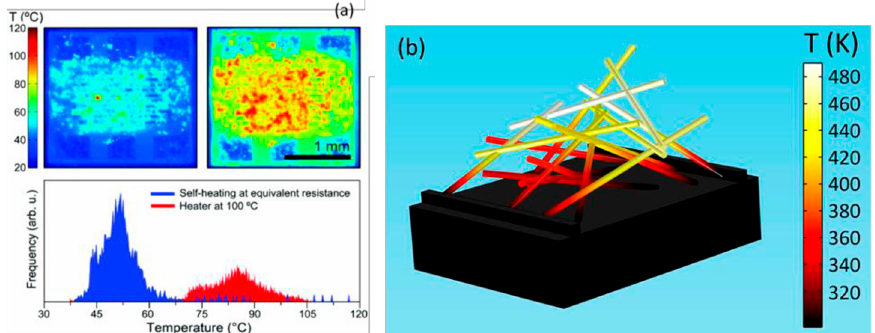
Figure 6. ( a ) Experimental observations (thermal micrographs) of hot-spots in random networks of CNF operated (left) in self-heating mode and (right) with an external heater. Clearly, the temperature pattern in self-heating mode concentrates in some central regions of the nanowire network. This is also seen as disperse high-temperature spikes in the blue histogram of the micrographs above, corresponding to the self-heating operation. Reproduced from Ref. [38] with permission from the Royal Society of Chemistry. ( b ) 3D model of the simulated temperature profile in a random network of nanowires (d = 60 nm, σ = 100 S·m − 1 , and κ = 1 W·m − 1 ·K − 1 ) operated at 6.8 μ W. The nanowire portions in direct contact with the substrate remain cooler than those located further away from the substrate. Reproduced from Ref. [40], with permission from